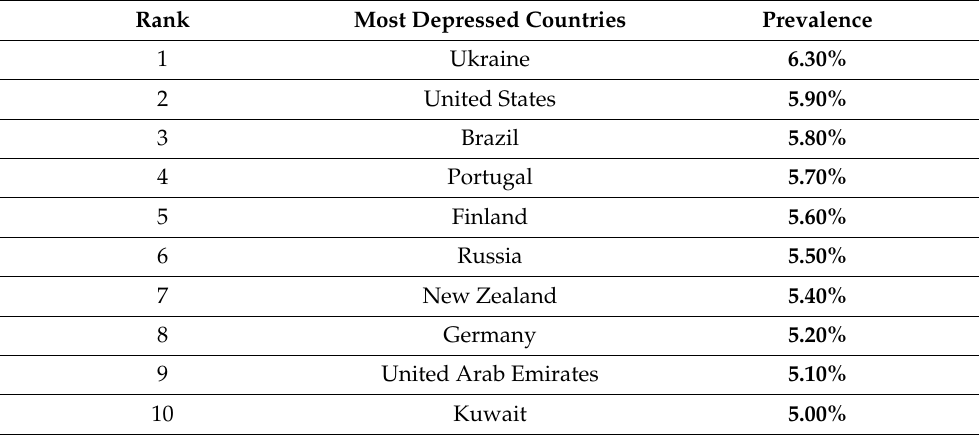
Table 1. Prevalence of depression in the world